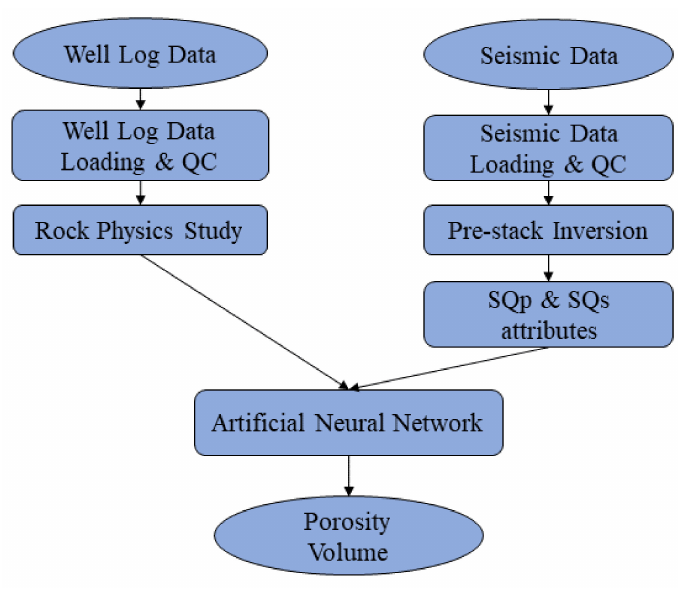
Figure 5. The workflow for reservoir characterization of HPHT zone in Malay